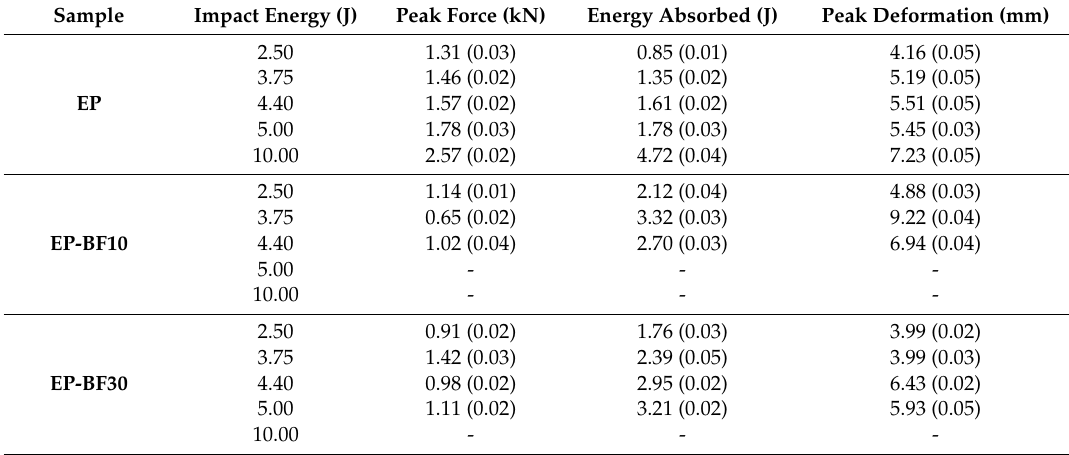
Table 3. Data analysed from the force displacement graphs of EP, EP-BF10 and EP-BF30 at the first range of the impact energy level.